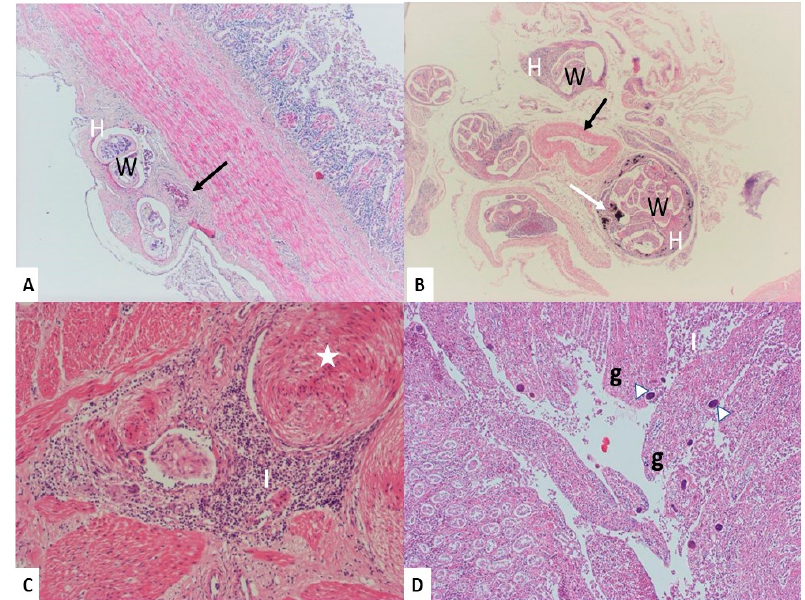
Figure 1. Effect of the parasite in the intestine. ( A ) Adult worms (W) are seen in the thickened walls of the serosal vein (H). Note the normal thickness of the artery (black arrow). ( B ) Brownish pigment–laden macrophages (white arrow) around the worm (W) in the thickened wall of the mesenteric veins (H). ( C ) The vein lumen was almost occluded due to marked myointimal hyperplasia in the veins of the muscular layer of the intestine (white star), with perivascular inflammatory reaction (I). ( D ) Several schistosome eggs (white arrowheads) present in the intestinal lamina propria and surrounded by an inflammatory reaction of lymphocytes and plasma cells (I); the intestinal villi are markedly blunted (g). Hematoxylin and eosin stain (100×).